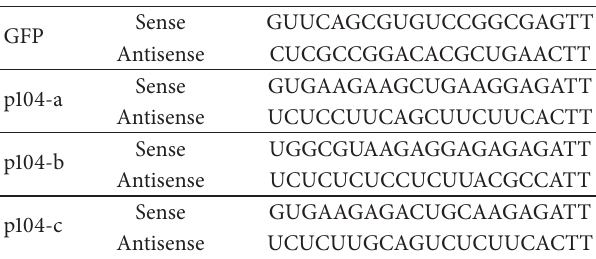
Table 1: Sequences of siRNA used in p104